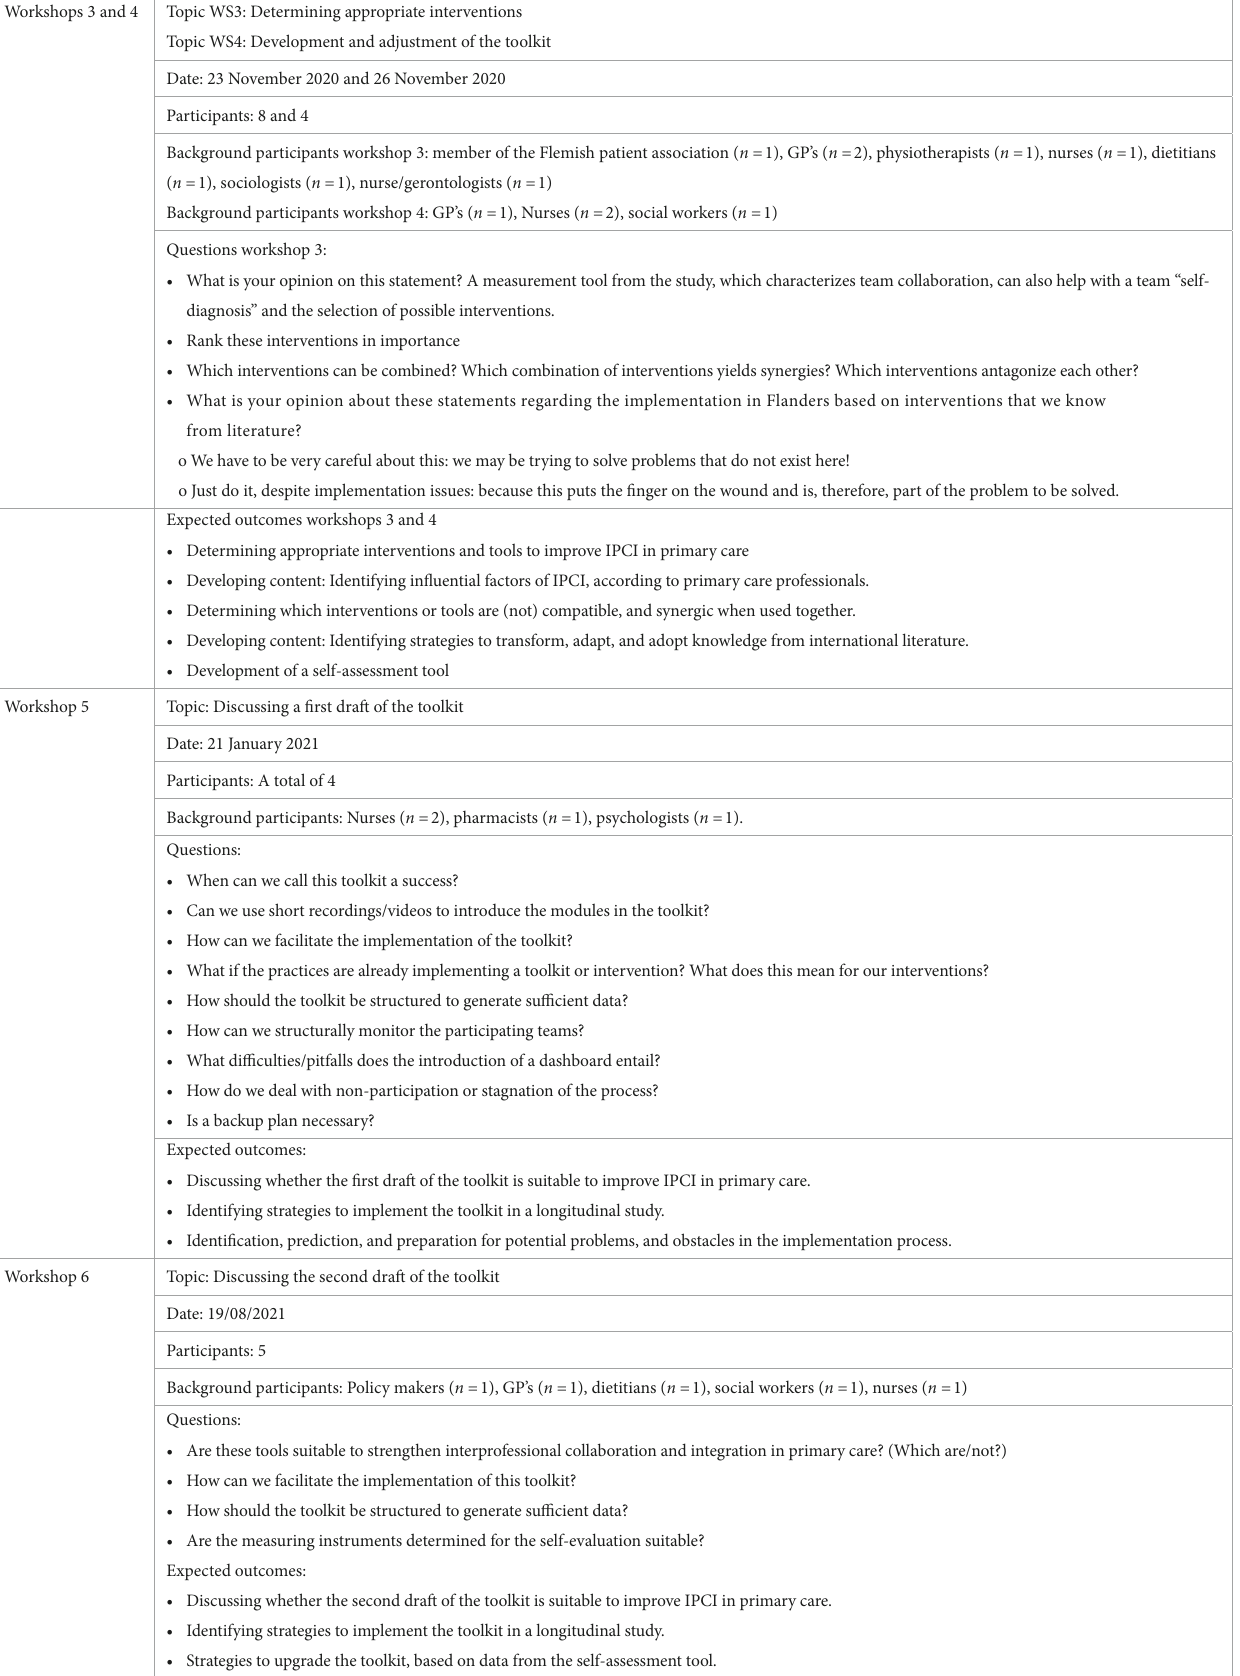
TABLE 5 Overview of the co-design workshop sessions: topic, date, # participants, background participants, and the questions. Workshops 3 and 4 Topic WS3: Determining appropriate interventions Topic WS4: Development and adjustment of the